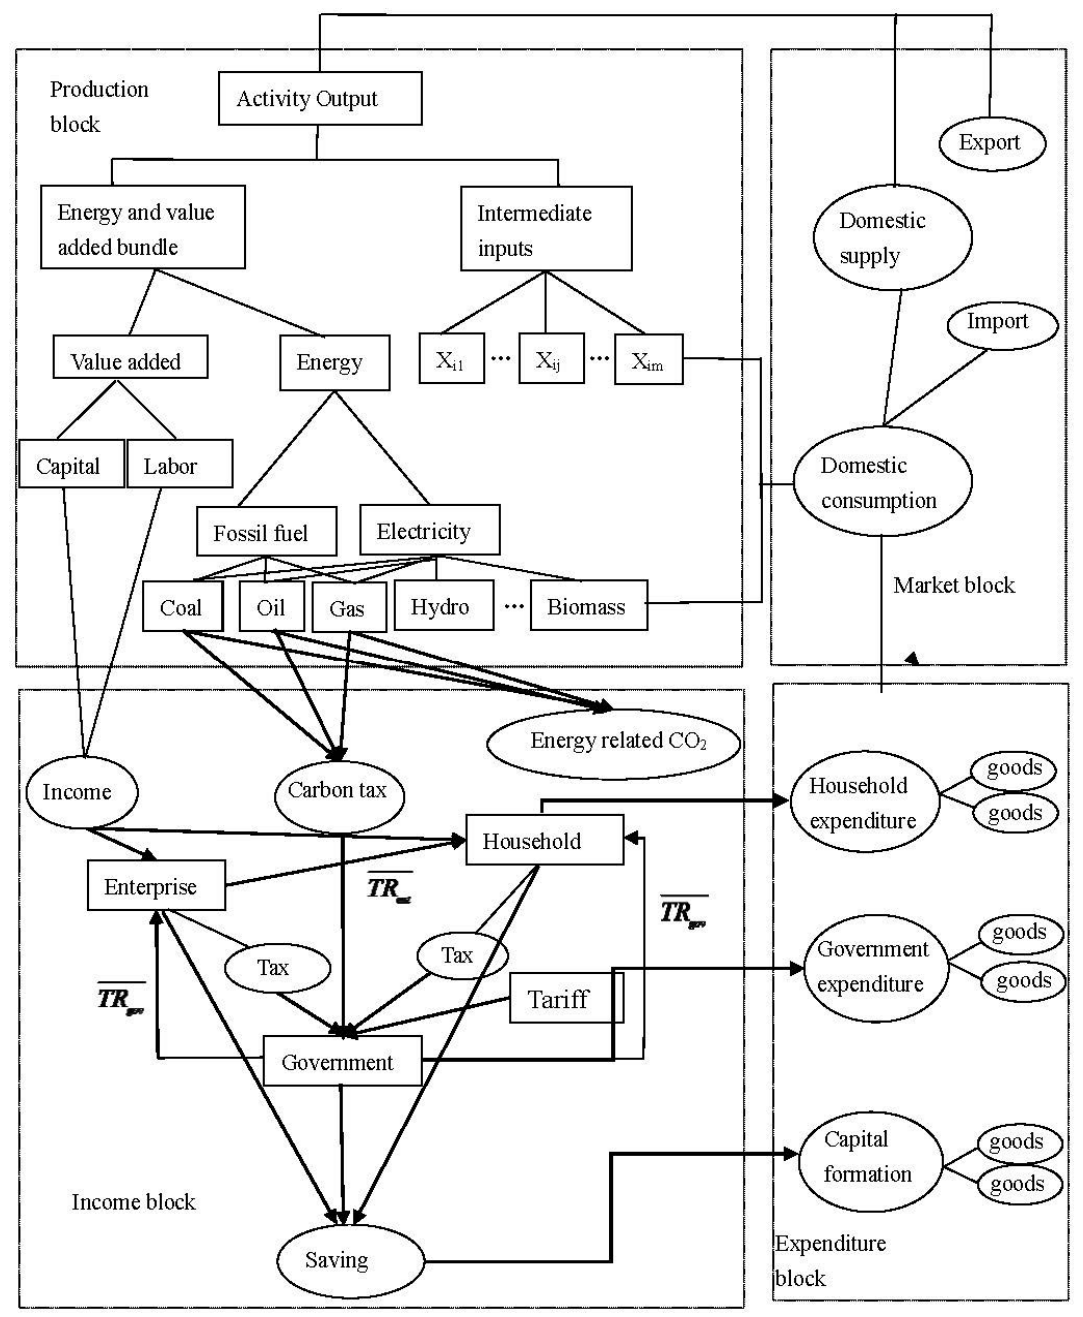
Figure 1. Overview of China’s AIM/CGE model structure (for one